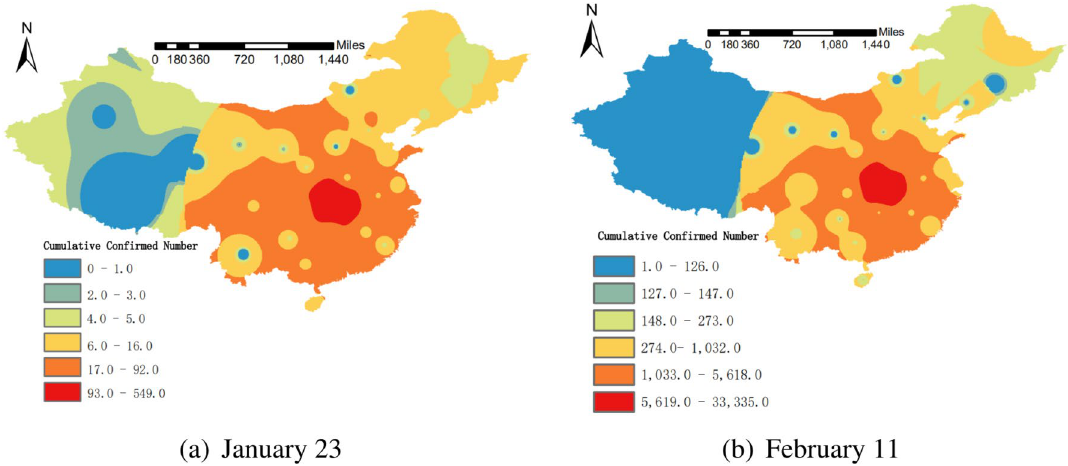
Figure 1. Time-series diagram of spatio-temporal Moran’s I index changes. Maps constructed using ArcGIS 10.2 (https:// s2. loli. net/ 2022/ 01/ 11/ MwZ28 1HAeB bN3uP.